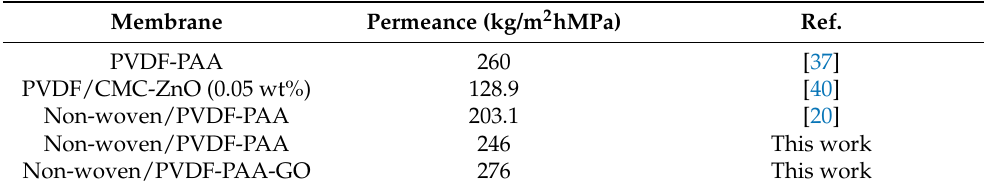
Table 2. Comparison of pure water permeance values with those of various membranes stated in the literature and with those of our composite